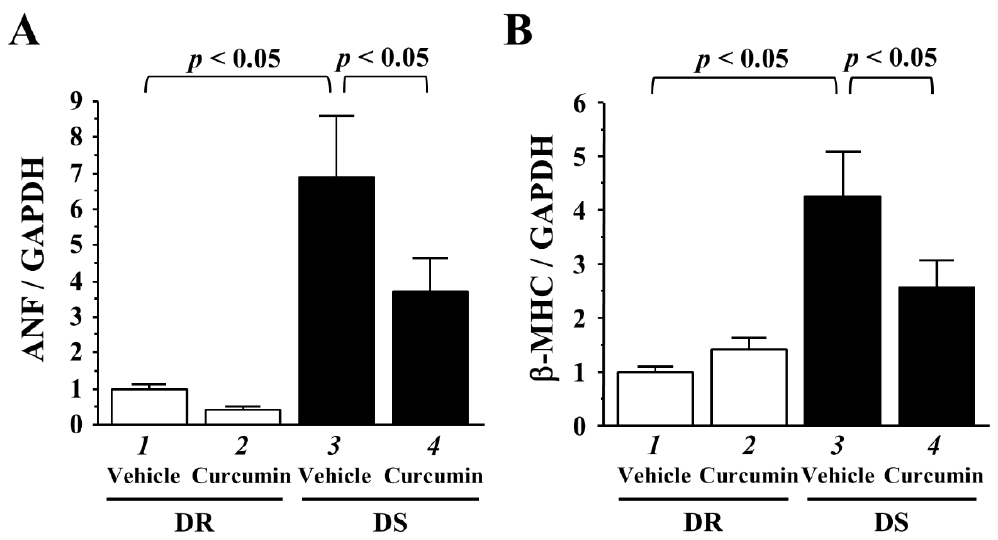
Figure 4. Curcumin significantly prevented the transcriptions of hemodynamic overload-induced hypertrophy-response genes in the LVs of DS rats. ( A , B ) The mRNA levels of atrial natriuretic factor (ANF) ( A ) and beta-myosin heavy chain (β- MHC) ( B ) of LV tissues in each rat were quantified and normalized to glyceraldehyde 3-phosphate dehydrogenase (GAPDH). All values were normalized to DR vehicle group, which was set at 1.0 as the control.